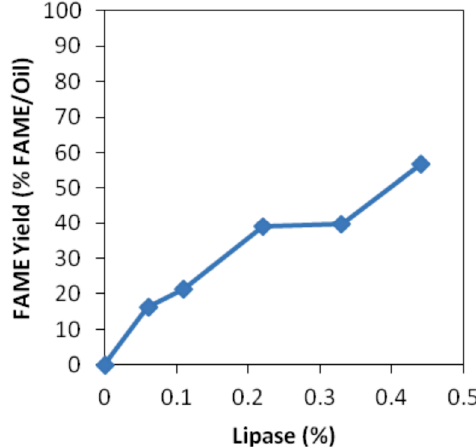
Fig. 8. Effect of molar ratio of methanol to oil on FAME yield (0.28% lipase, 72